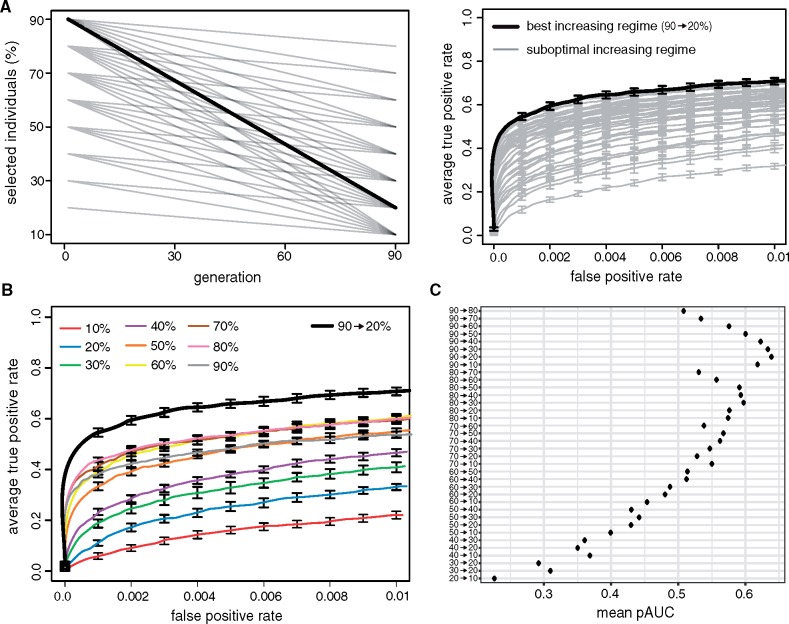
Increasing the strength of selection during an E&R study enhances the power to identify QTNs. (A) Approach for identifying the best increasing regime. We evaluated the performance of all possible increasing regimes using steps of 10% (left panel). The best selection regime (bold) has the largest AUC (right panel). (B) The best increasing regime outperforms the evaluated constant regimes (steps of 10%). (C) Performance of each evaluated increasing regime (pAUC).